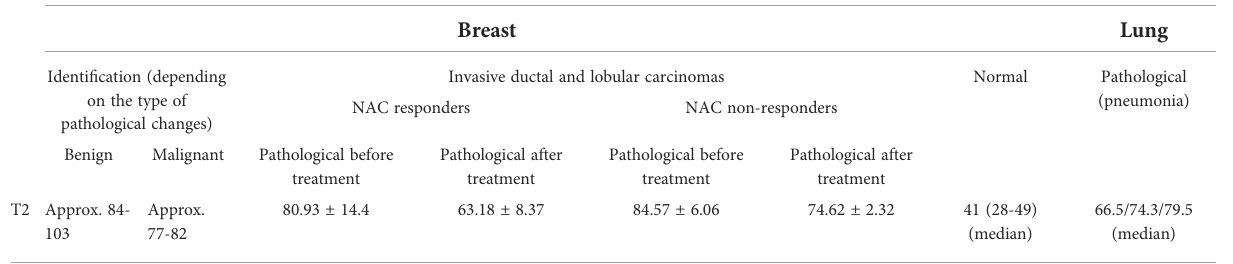
Identi fi cation (depending on the type